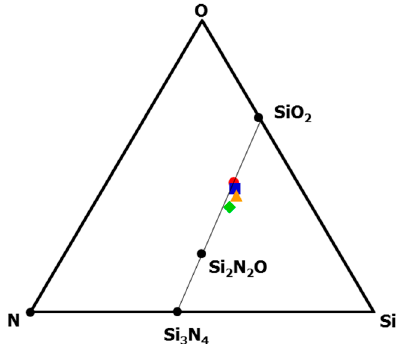
Figure 7. Compositions of EtOSZ-derived samples after pyrolysis at 800 °C ( █ ), and subsequent heat treatment at 1400 °C (0.3Si 2 N 2 O: 0.3SiO 2 : 0.1Si, ♦ ), 1600 °C (0.25Si 2 N 2 O: 0.375SiO 2 : 0.125Si, (cid:78) ), 1800 °C (0.2Si 2 N 2 O: 0.4SiO 2 :0.2Si, ● ) in N 2 .